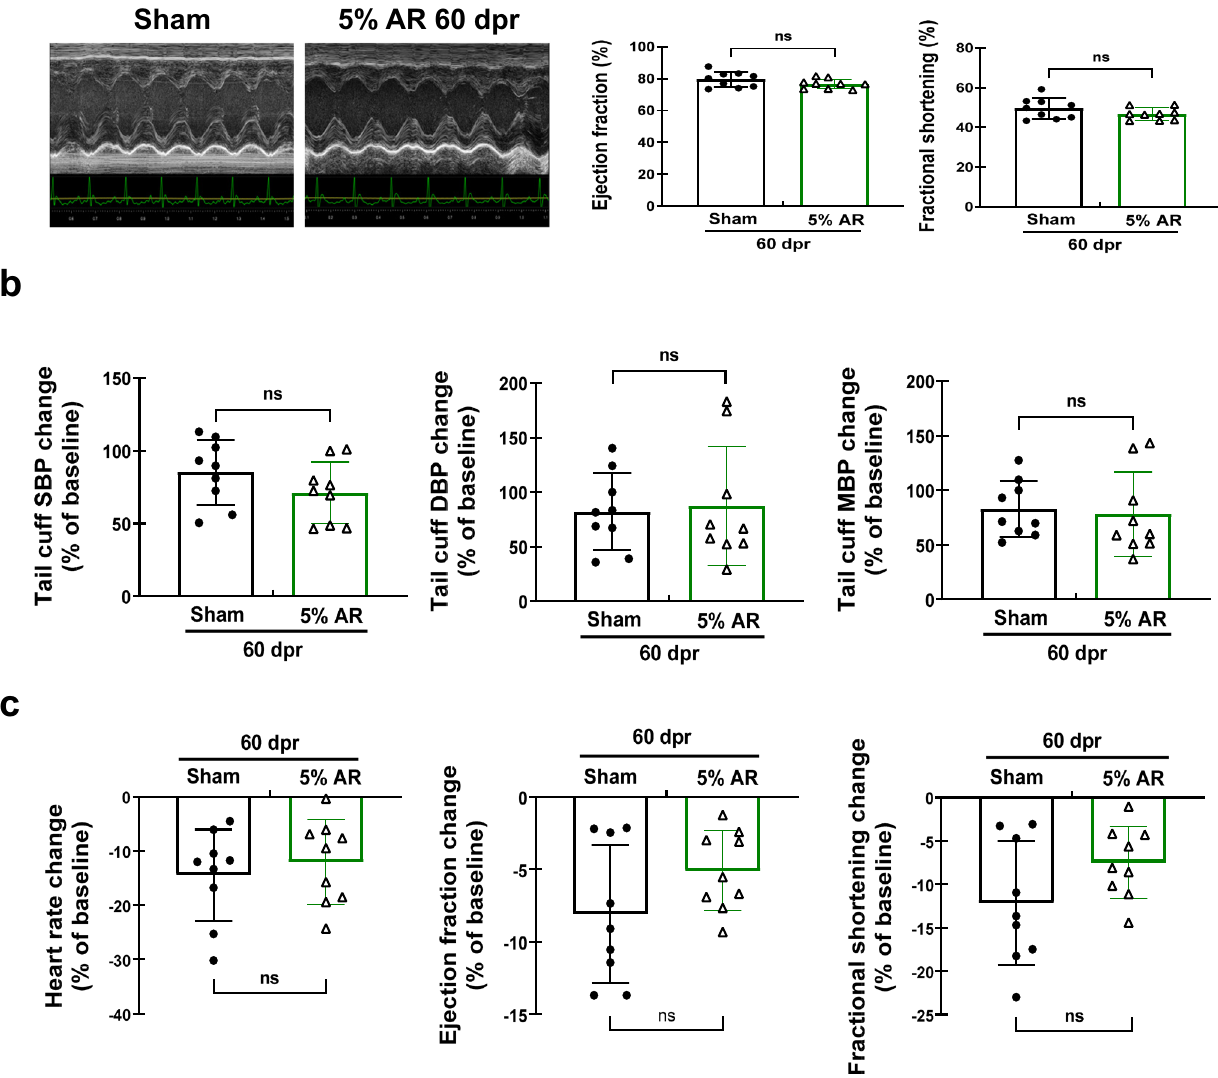
Fig. 7 Long-term cardiac function under hemodynamic stress after 5% modi fi ed apical resection surgery in 1-day-old neonatal rats. a Echocardiography for left ventricle ejection fraction and fractional shortening at baseline before phenylephrine injection in rats at 60 days post resection (dpr) ( n = 9). b Tail cuff blood pressure measurements including systolic blood pressure (SBP), diastolic blood pressure (DBP), and mean blood pressure (MBP) ( n = 9). Data were presented as change from baseline (%) once SBP increased over 40%. c Echocardiography for heart rate, left ventricle ejection fraction, and fractional shortening when SBP increased over 40% from baseline after phenylephrine injection ( n = 9). Data were presented as change from baseline (%). ns not signi fi cant. All data are expressed as means ±